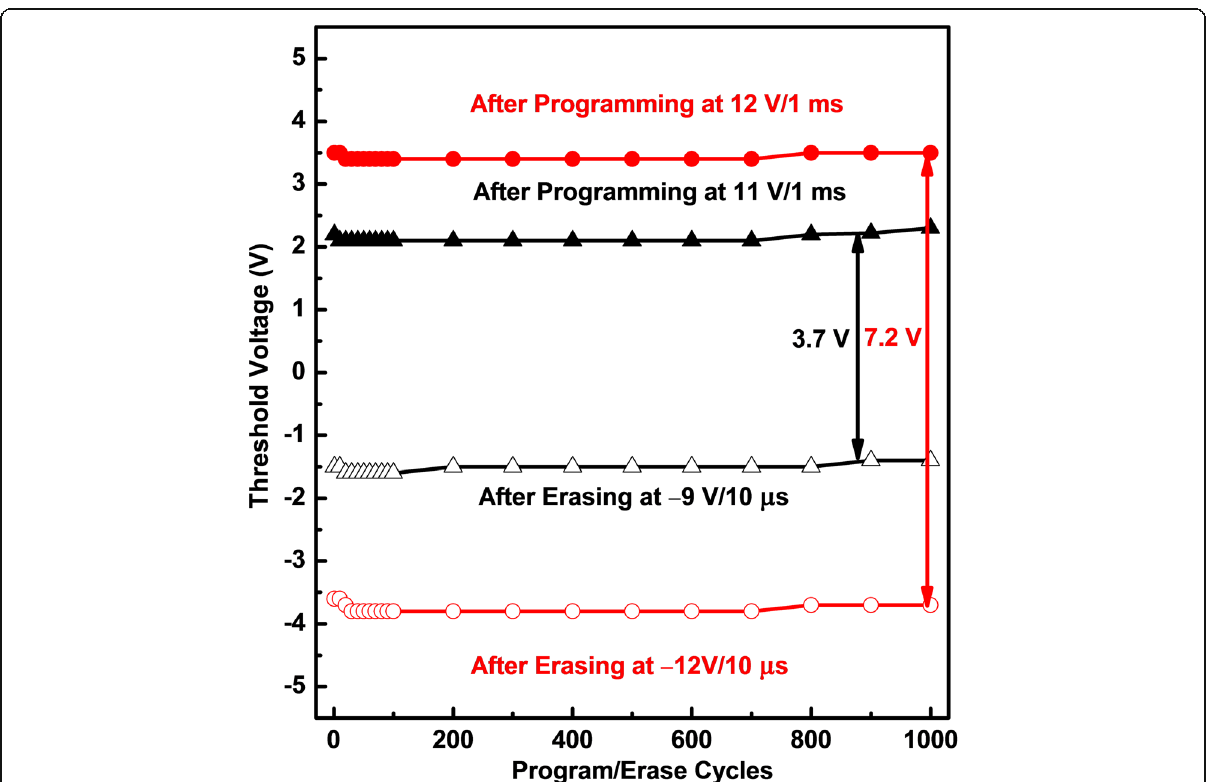
Fig. 4 The endurance characteristics of the a-IGZO TFT memory device as a function of P/E cycles